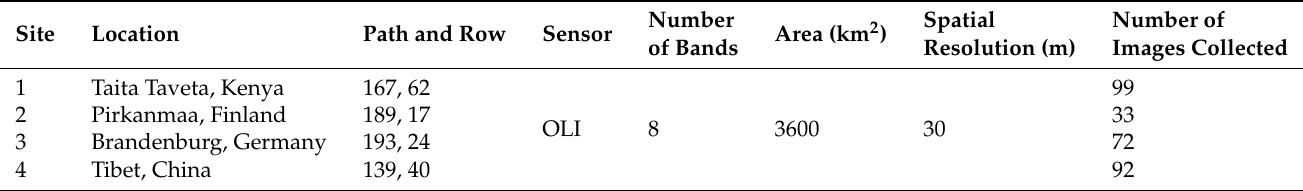
Table 2. Landsat 8 Operational Land Imager (OLI) images acquired from January 2014 to Decem- ber